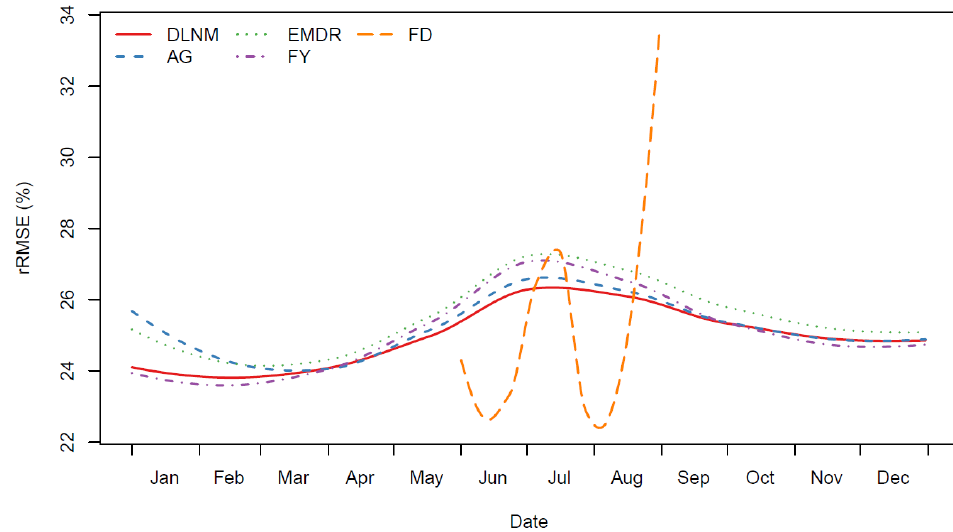
Figure 5. Cross-validated relative RMSE (rRMSE) along the year for each strategy and the benchmark model. The rRMSE is defined as the square root of the mean square prediction error divided by the mean of the raw response. In this figure, the computed rRMSE is smoothed by locally weighted regression (LOESS). DLNM, distributed lag nonlinear model; AG, aggregation of response; EMDR, EMD-regression; FD, functional with daily curves; FY, functional at the yearly level.